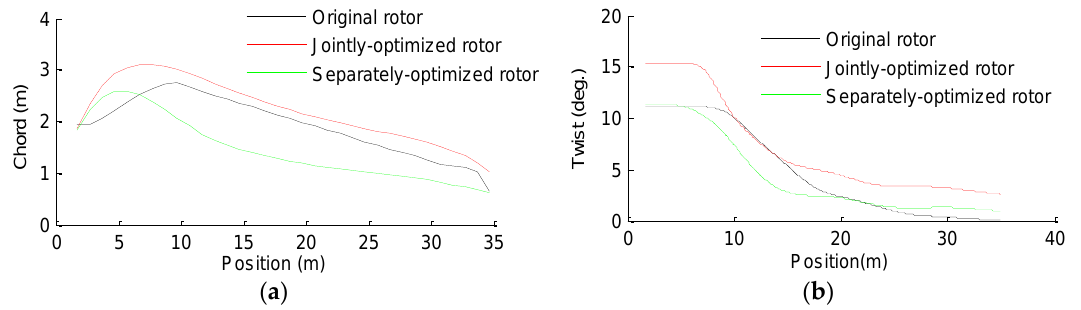
Figure 8. Distributions of chord length and twist angle for the original and optimized blades. ( a ) Chord length; ( b ) Twist angle.